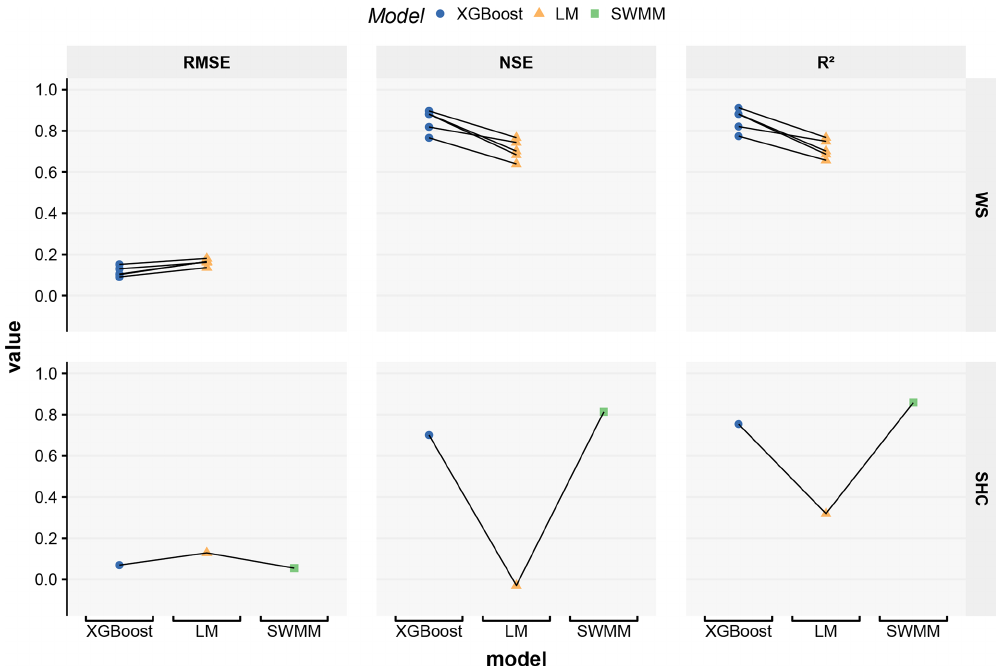
Figure 5. Prediction accuracies of the various models built for the Washington Street SuDS site (WS) and Shayler Crossing Watershed (SHC). The prediction accuracies are evaluated in terms of the root mean square error (RMSE), coefficient of determination ( R 2 ), and Nash– Sutcliffe coefficient of efficiency (NSE). The RMSE units are liters per second (hereafter L/s) for WS and cubic meters per second (hereafter m 3 /s) for SHC. Each data point in the figure shows the prediction accuracy evaluated using a specific split of the data set. The prediction accuracies derived using the same test data set are connected by lines. The SWMM model for SHC was built by Lee et al. (2018a).